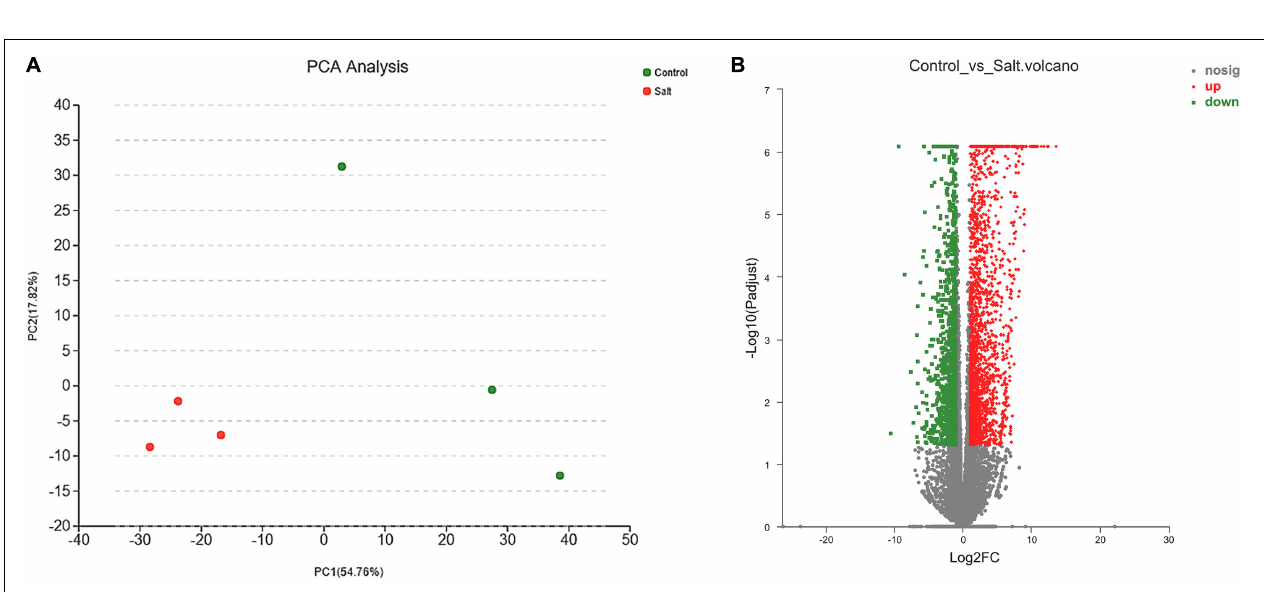
FIGURE 2 | (A) Principal component analysis (PCA) of salt-stressed and control groups. (B) Volcano map analysis of differentially expressed genes (red, green, and gray points represent upregulated, downregulated, and unchanged genes, respectively).